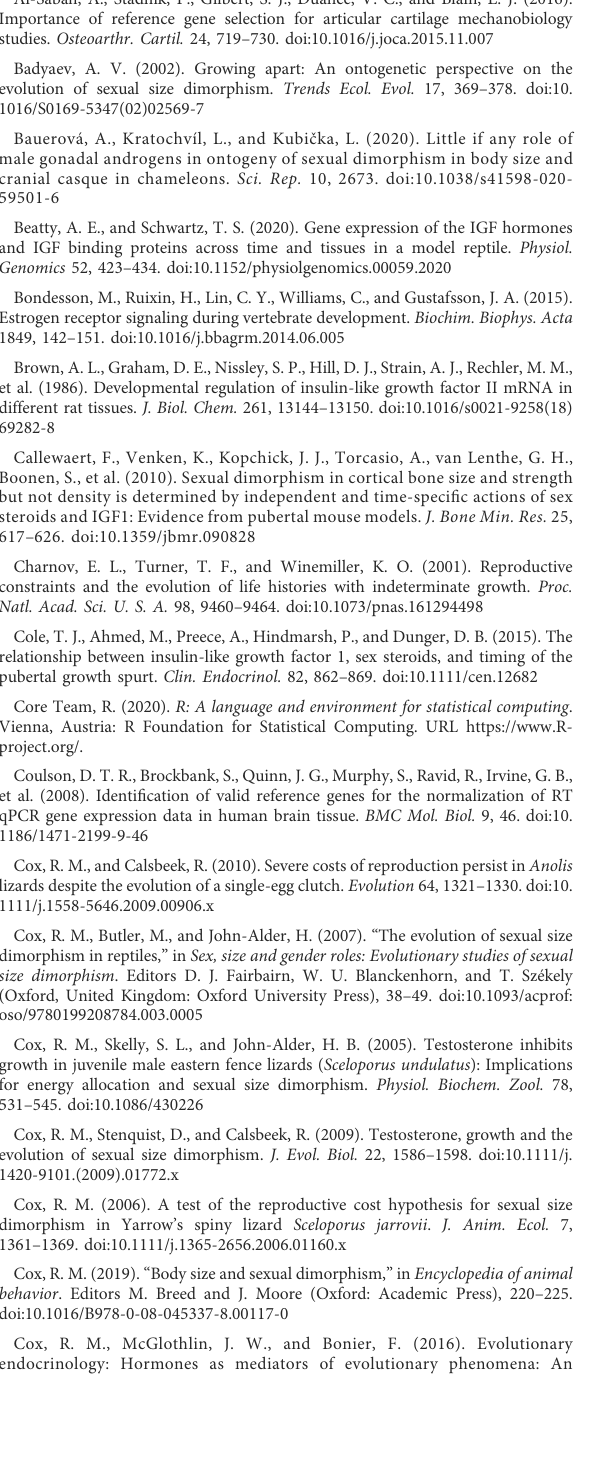
SUPPLEMENTAL FIGURE S2 Testosterone plasma levels across sex and age groups. The levels of the androgen became sexually dimorphic quite early in the ontogeny. They stayed low in females and vary alot but are higher among males. Age groups with measured gene expression are